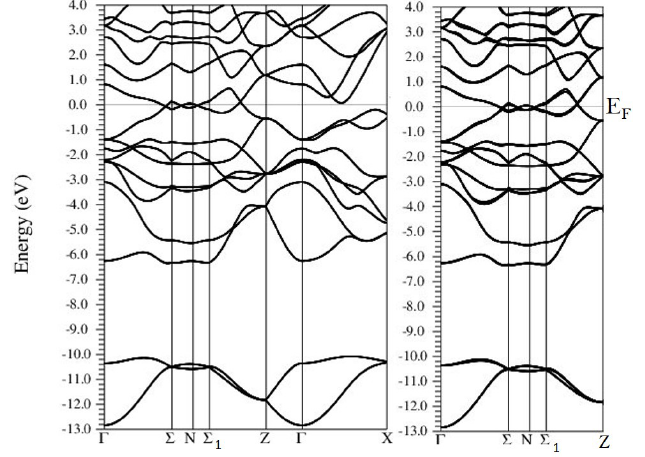
Figure 6. The band structure of NbP. The left panel does not include spin orbit coupling (SOC); the right panel includes SOC.